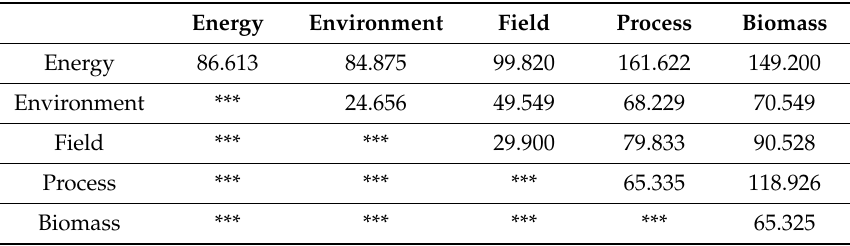
Table 6. Relationships between the terms of the